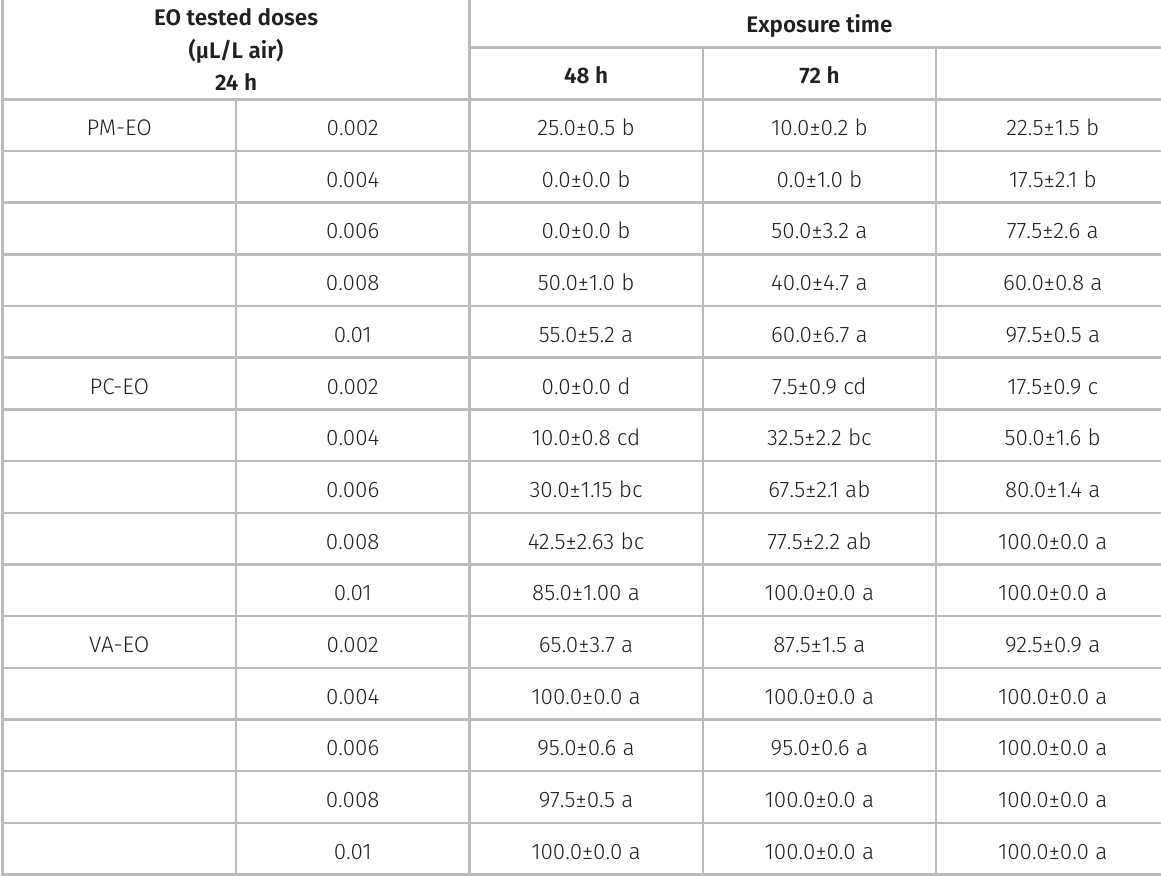
Table II. PM-EO, PC-EO and VA-EO fumigant activity (percentage adult mortality) against Z. subfasciatus